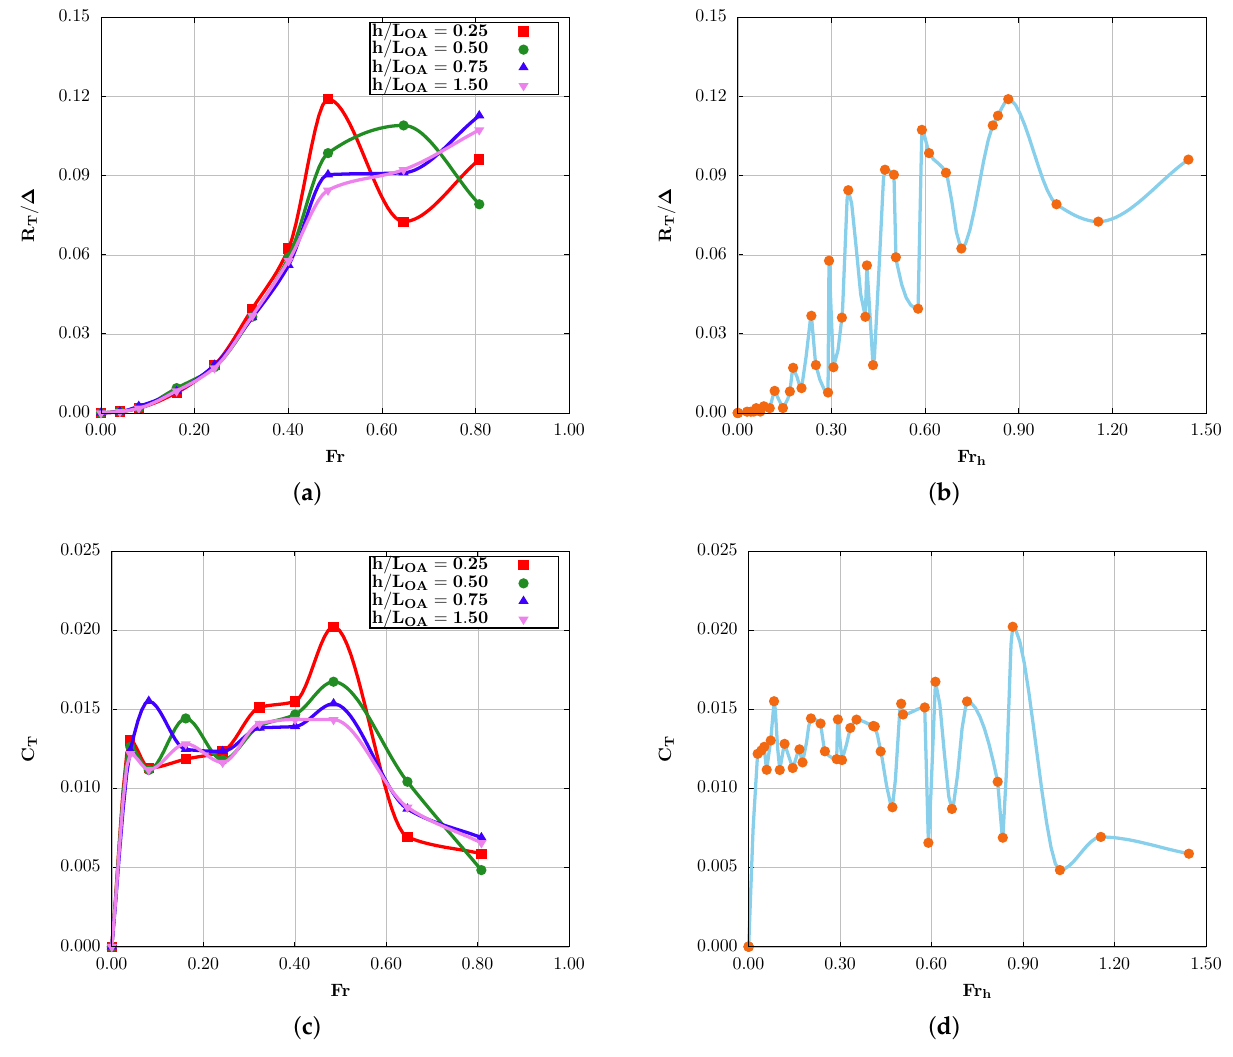
Figure 8. The effect of advance speed and depth on the total resistance of the catamaran; ( a ) non- dimensionalized total resistance versus Fr , ( b ) non-dimensionalized total resistance versus Fr h , ( c ) total resistance coefficient versus Fr , ( d ) total resistance coefficient versus Fr h